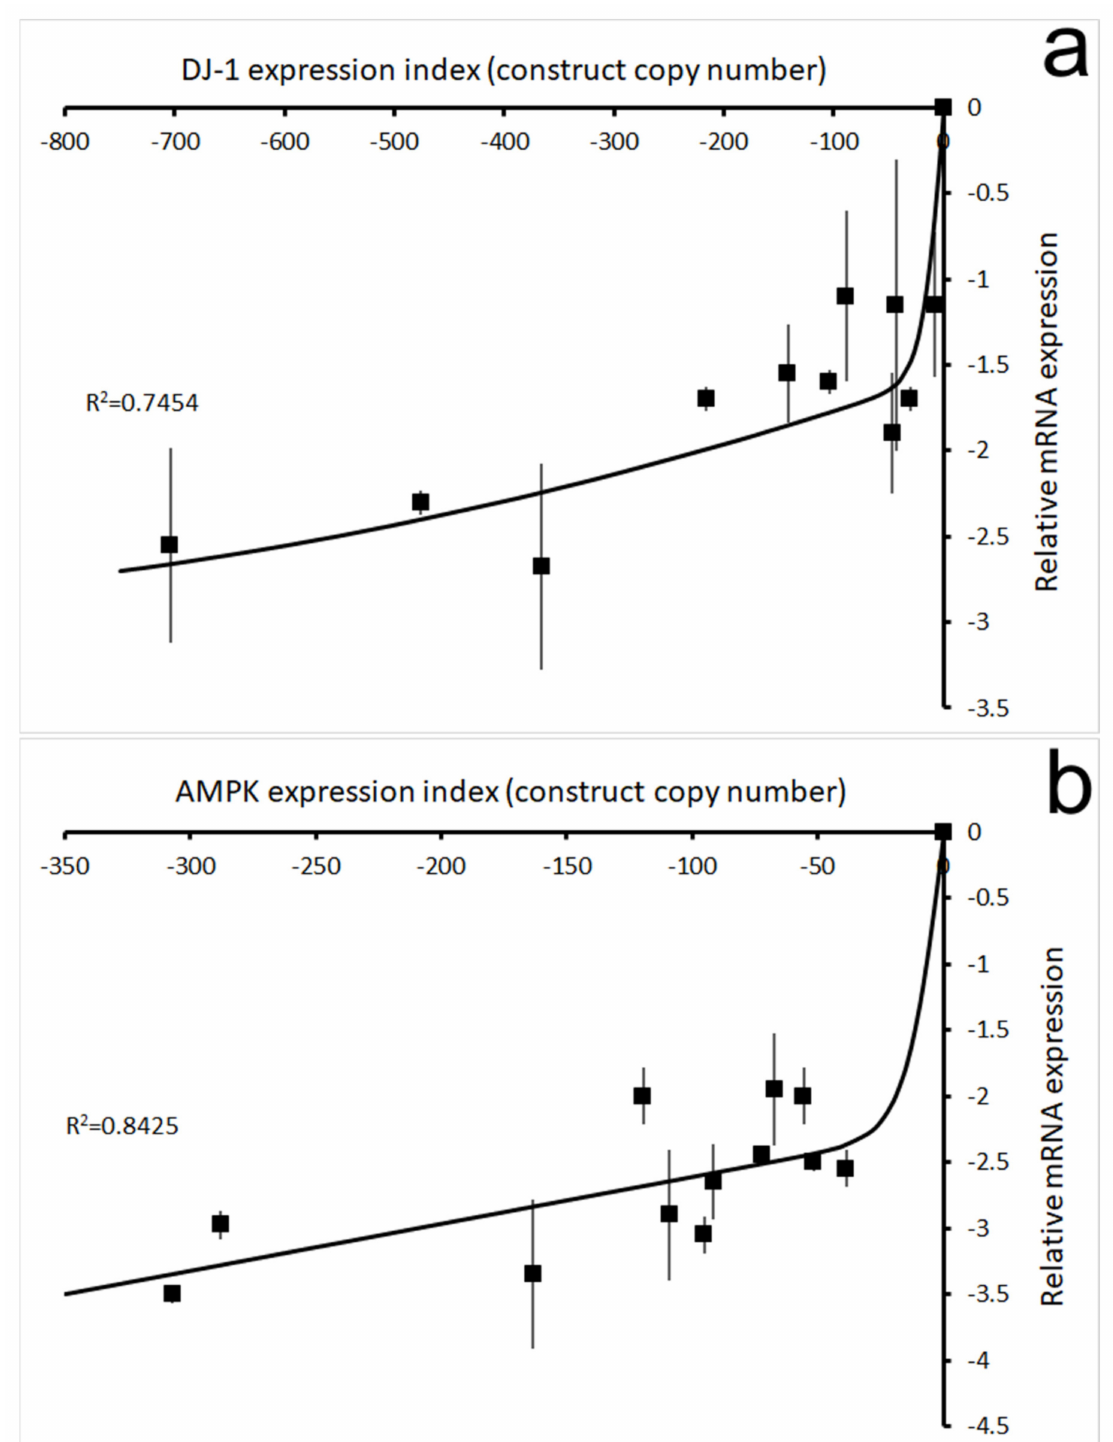
Figure 2. Correlation of construct copy numbers with mRNA expression levels in cotransformant strains (cell lines) containing both pPROF688 (DJ-1 antisense construct) and pPROF362 (AMPK antisense construct). The mRNA levels (Y axis) were measured in qRT-PCR cycle number differences from those for the filamin gene (the loading control reference gene) and then expressed as the difference from the level in the parental strain AX2 (which, therefore, has a relative expression level of 0). ( a ): The relationship between DJ-1 antisense inhibition construct (pPROF688) copy numbers and DJ-1 mRNA levels. The figure shows the coefficient of variation, R 2 , representing the fraction of the variance in expression that was attributable to the regression relationship. The regression using a sigmoidal function (modified tanh ( × )) was highly significant at p =